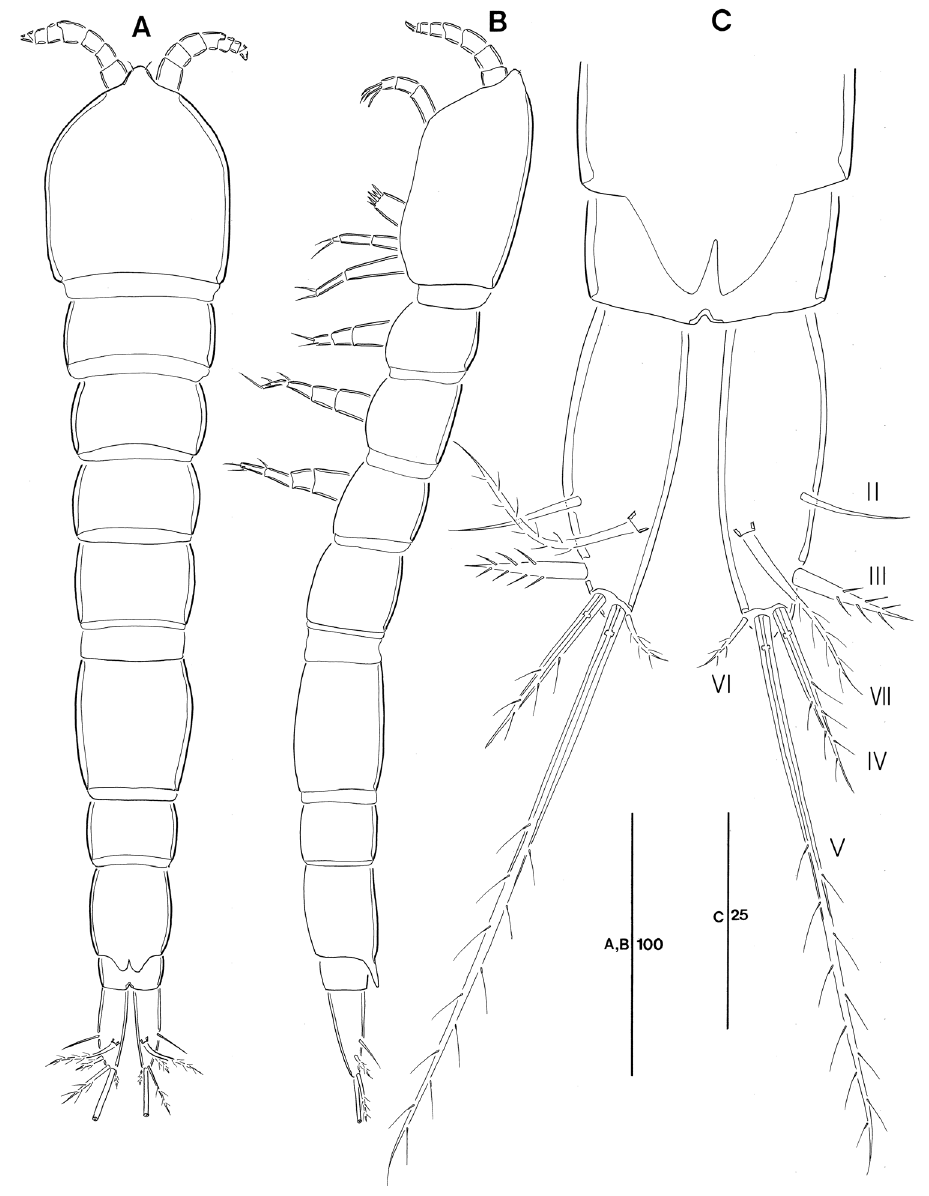
Figure 1. Leptopsyllus ( Leptopsyllus ) pundius sp. n. ( ♀ ). A habitus, dorsal B habitus, lateral C pseudoper- culum, anal somite, and caudal rami, dorsal. Scale bars are in microns. any surface ornamentation; exp 1-segmented, with 2 lateral bare and 2 distal modified setae; proximal endopodal segment with 1 pinnate abexopodal seta; distal endopodal segment armed with 2 bare short spines laterally, 1 naked and 2 spine-like setae